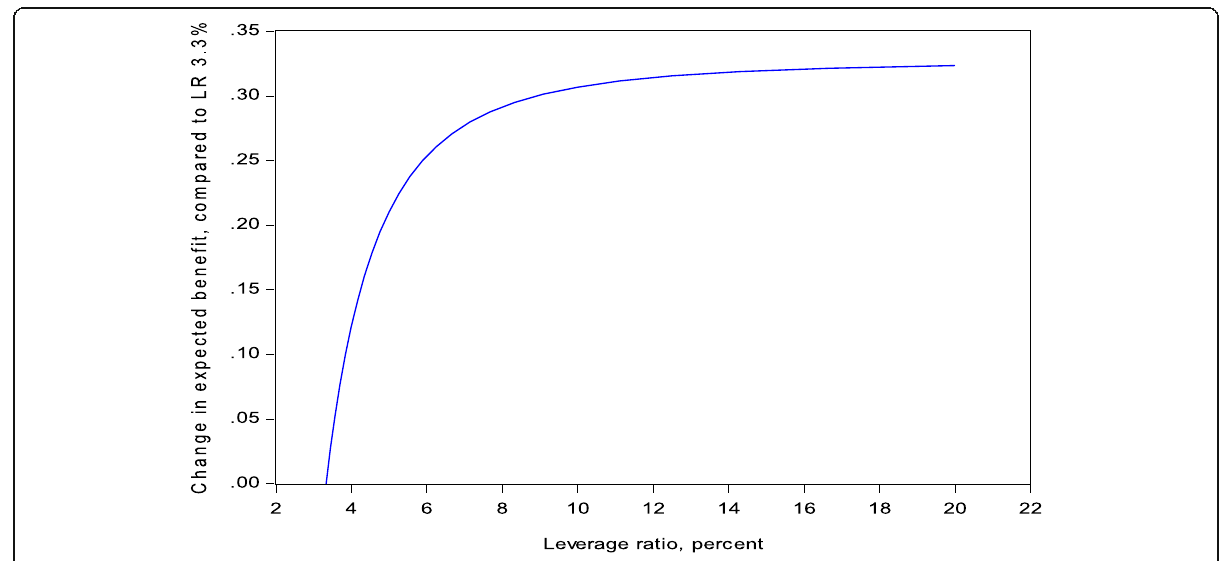
Fig. 2 Change in expected annual GDP benefits and leverage ratio of large banks in percent